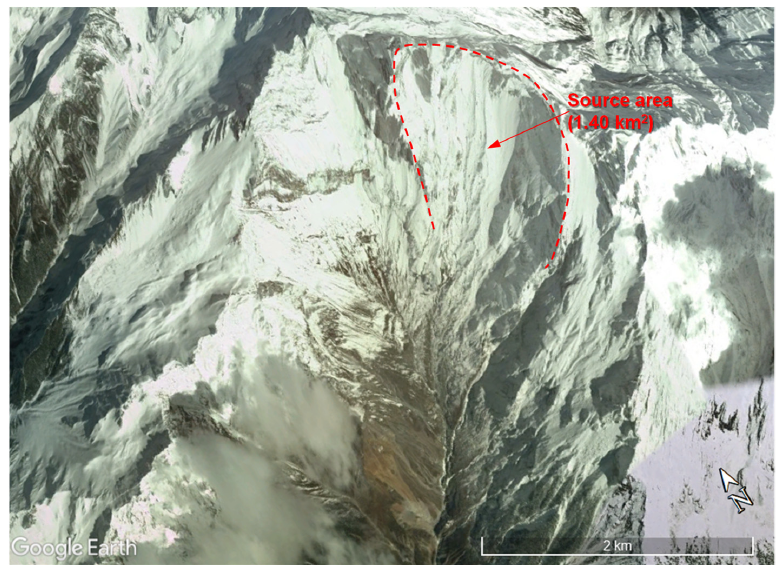
Figure 5. Oblique view of the debris flow source area.